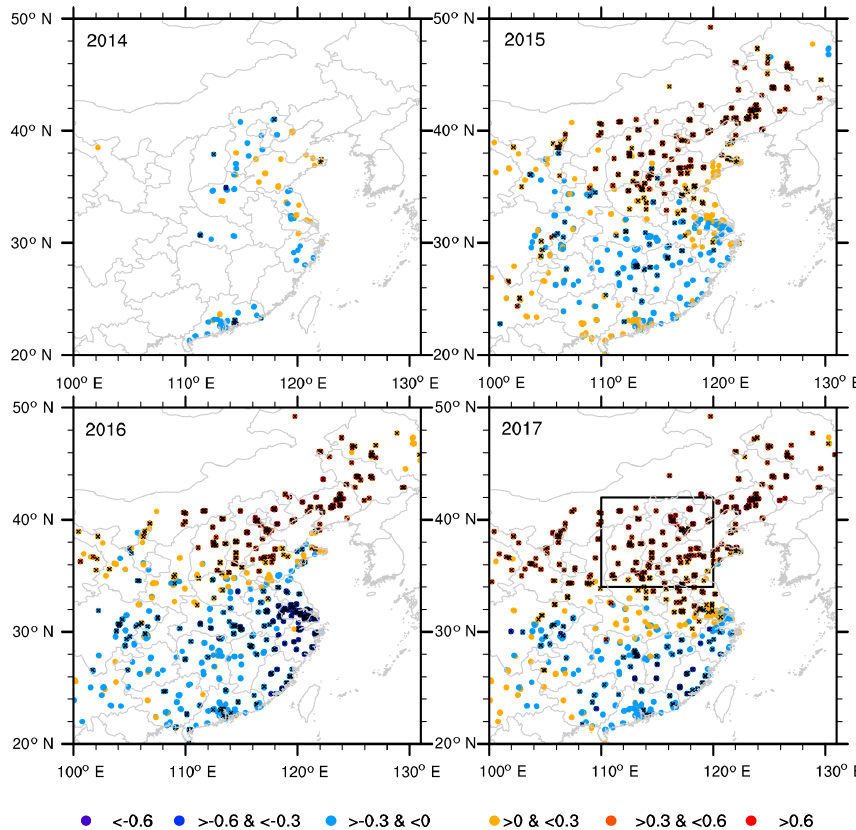
Figure 5. The correlation coefficients between the daily MDA8 and OWI from 2014 to 2017. The black crosses indicate that the CC was above the 95% confidence level.